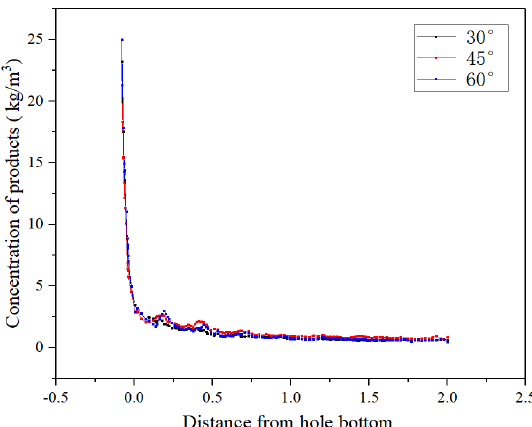
Figure 11. Concentration variations of processed products in the axial direction of the hole in the machining gap using different thread form angles.